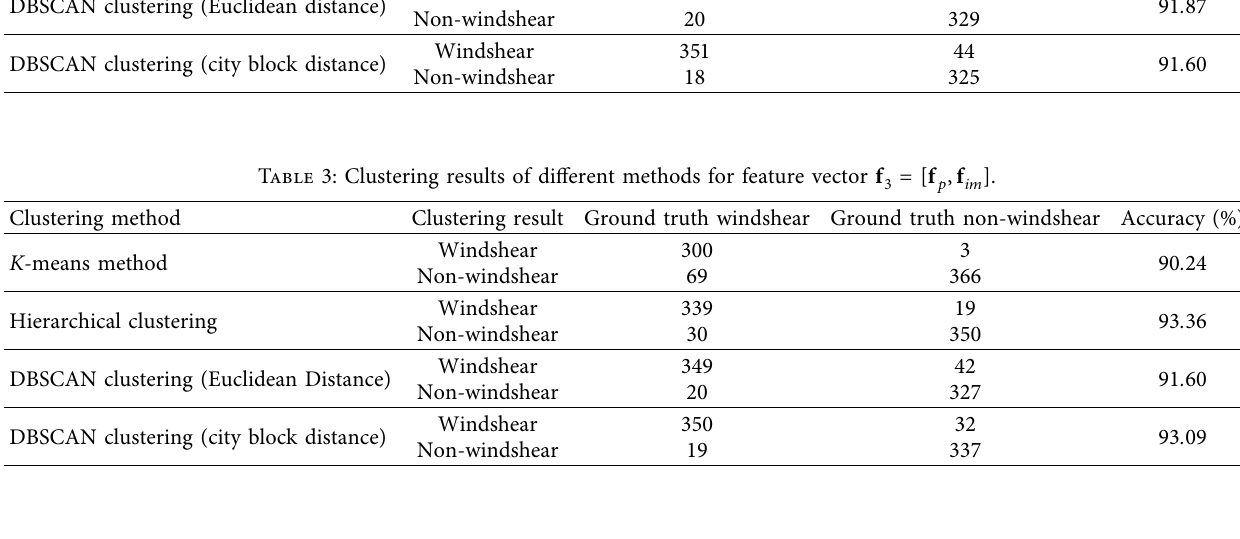
Table 2: Clustering results of diferent methods for feature vector f